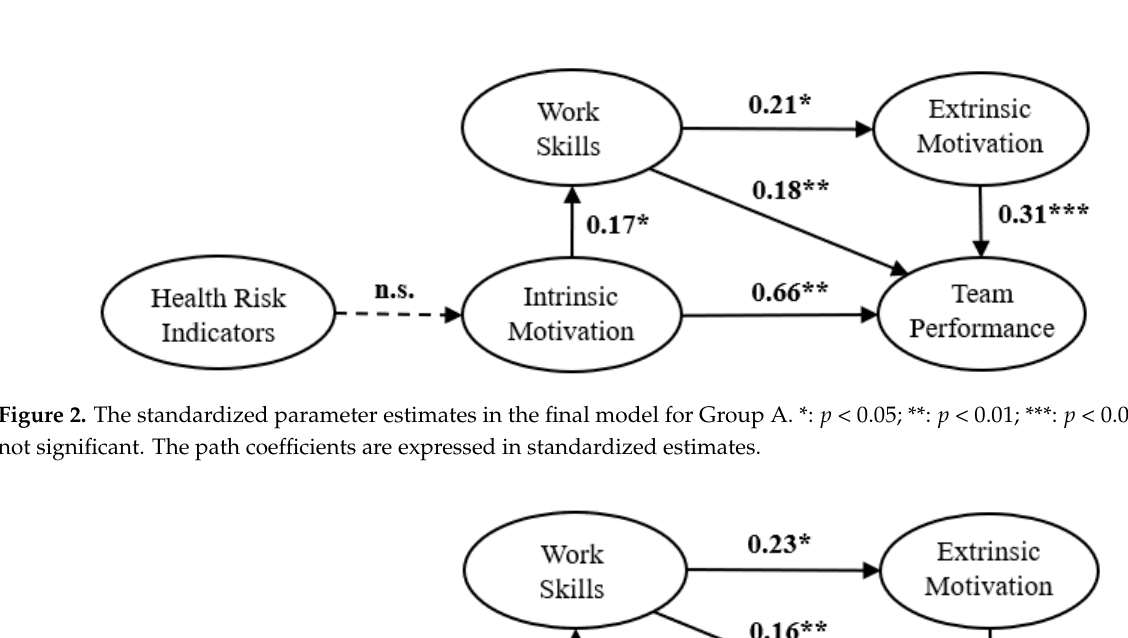
Table 6. The summary of direct, indirect, and total effects of path.